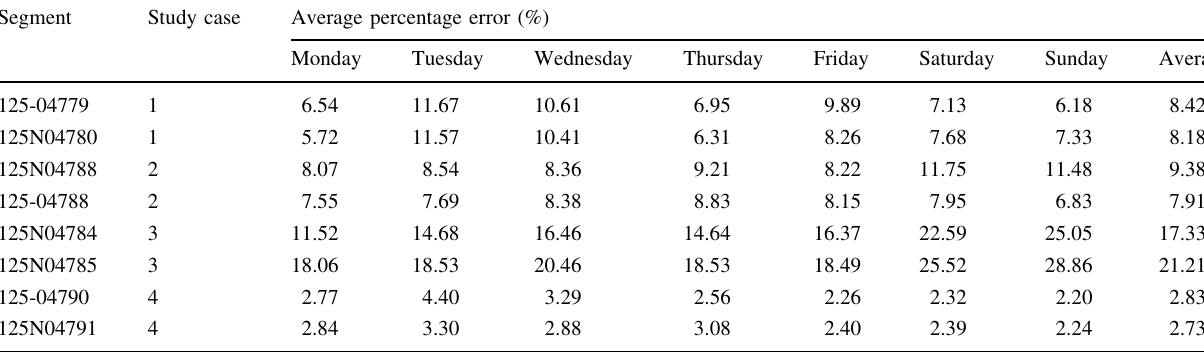
Table 7 Percentage prediction errors (Monday to Sunday) Segment Study